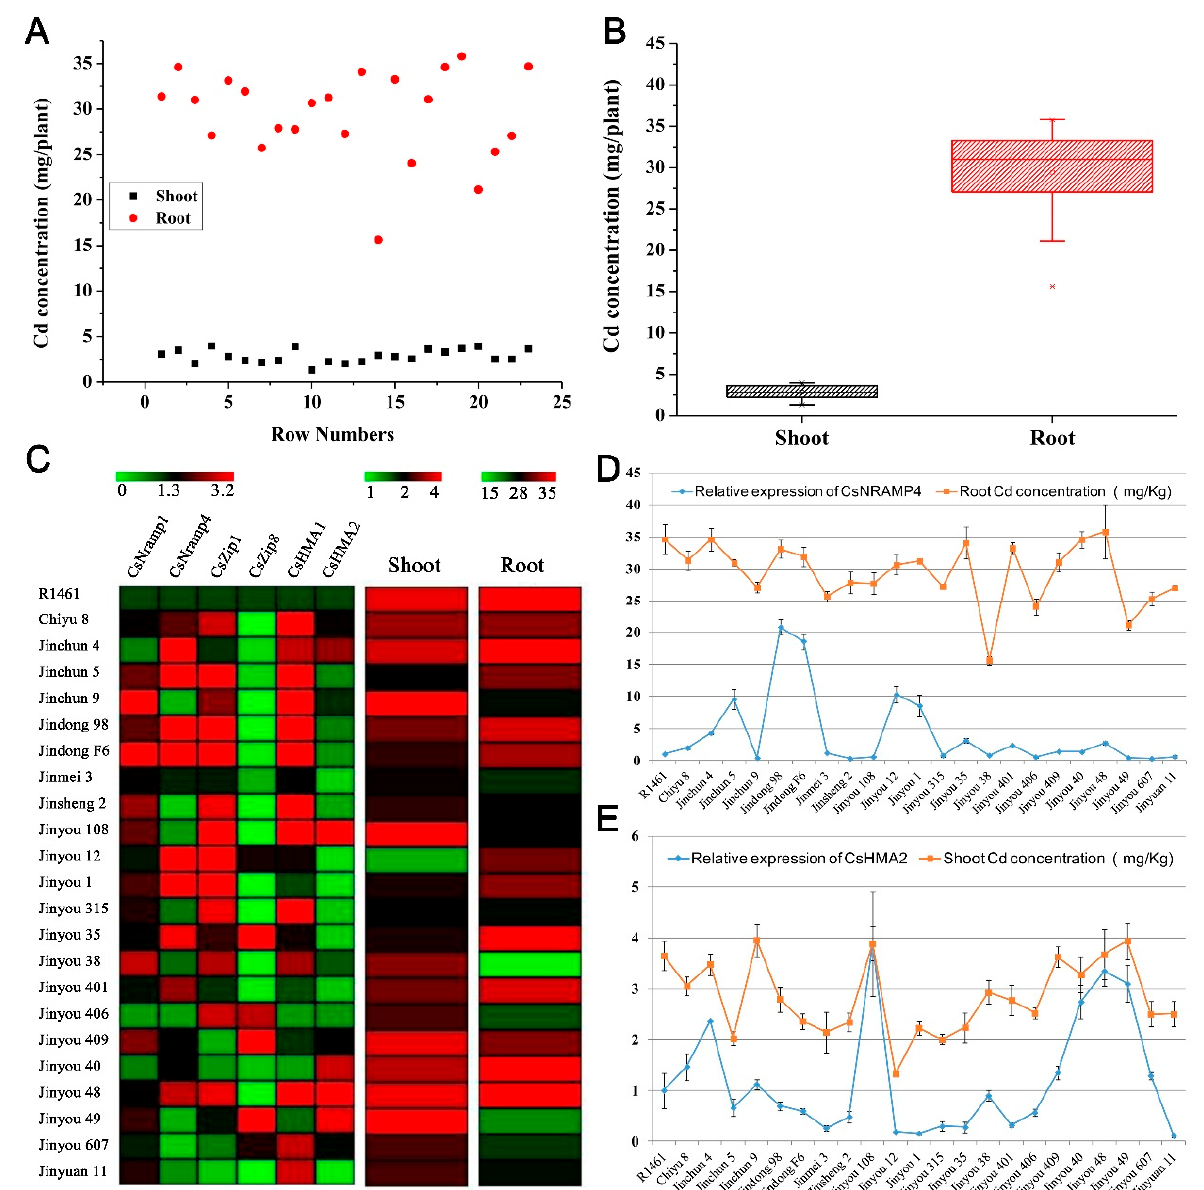
Figure 4. Correlation analysis of ionomics and gene expression profiles identified the major Cd accumulation genes in cucumber. ( A ) Distribution of Cd accumulation in the roots and shoots of 23 cultivated cucumber. The red circle represents shoots, and the black box represents roots. ( B ) Box–whisker plot Cd concentration of all 23 cultivated varieties identified by ICP-MS. ( C ) Hierarchical clustering of six Cd-related transporters expression and Cd accumulation in the shoots and roots of 23 cultivated varieties. Heat map represents the gene transcript level and Cd accumulation. ( D , E ) Association analysis of the expression of CsNramp4 ( D ) and CsHMA2 ( E ) in 23 cultivated varieties along with Cd content in the roots and shoots. Ten-day-old cucumber plants were grown in nutrient solution supplemented with 0 and 0.5 μ M Cd for 10 days.